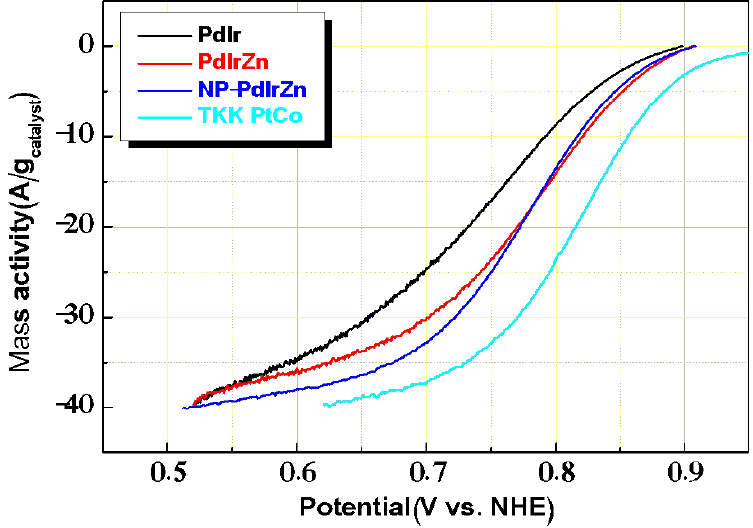
Figure 5. Mass ORR activity of PdIr, PdIrZn, NP-PdIrZn, and TKK PtCo catalysts by linear sweep voltammetry.